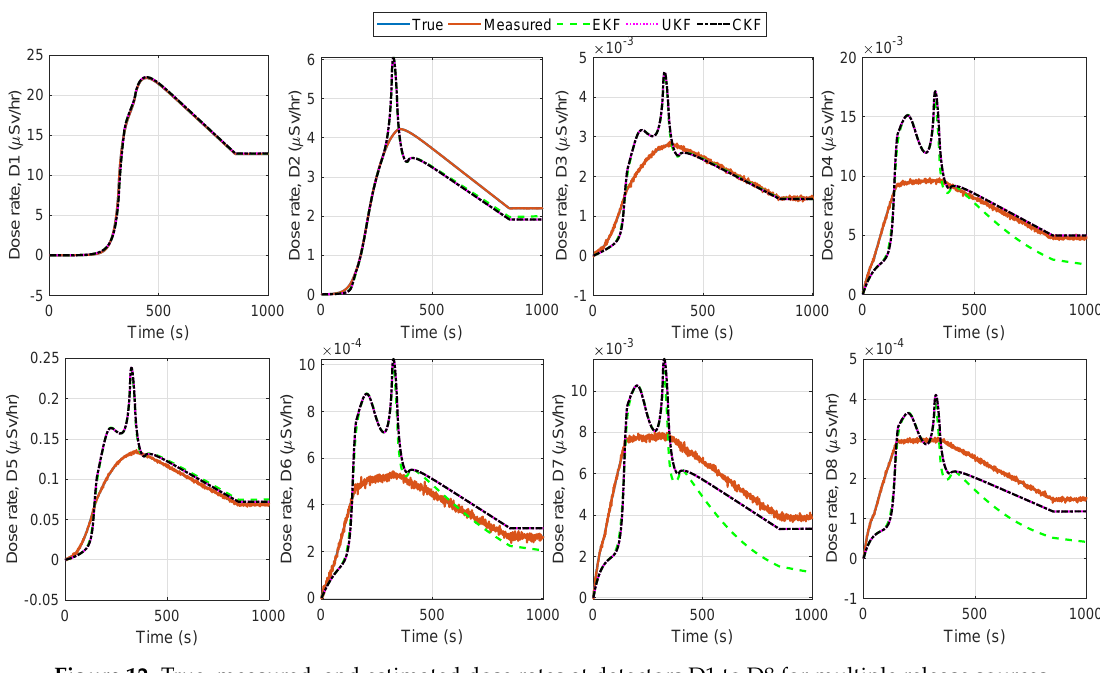
Figure 12. True, measured, and estimated dose rates at detectors D1 to D8 for multiple release sources.